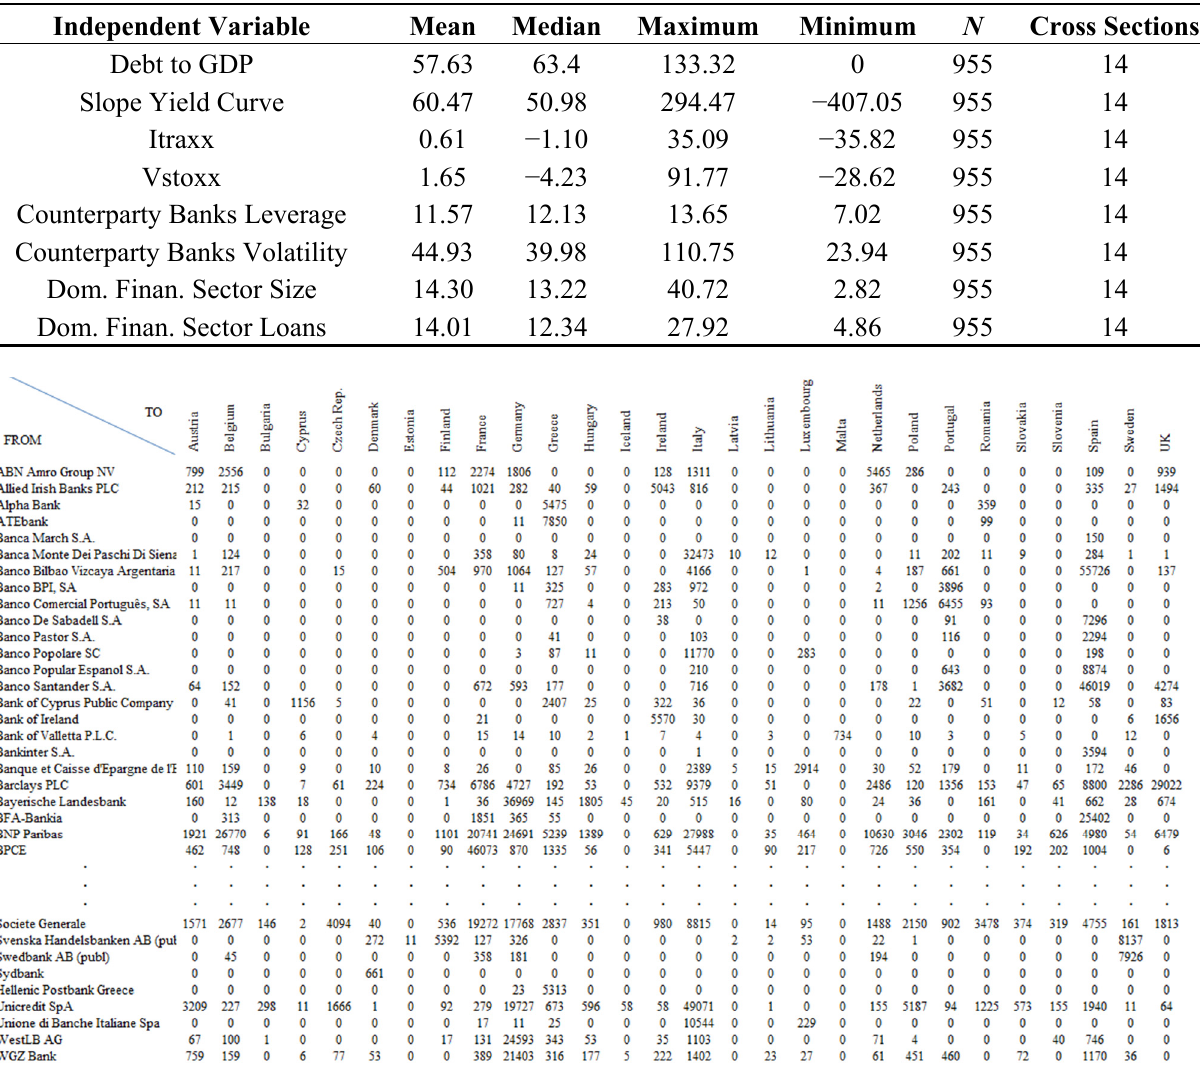
Table A4. Descriptive Statistics of the Independent Variables (long period).